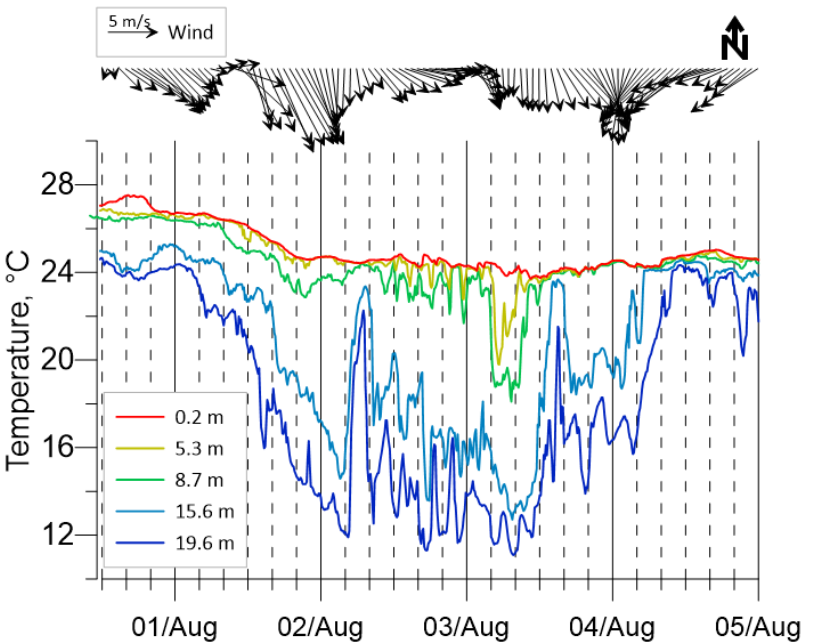
Figure 8. Sharp temperature decrease in August 2020. Upper panel—wind speed. Lower panel— water temperature.